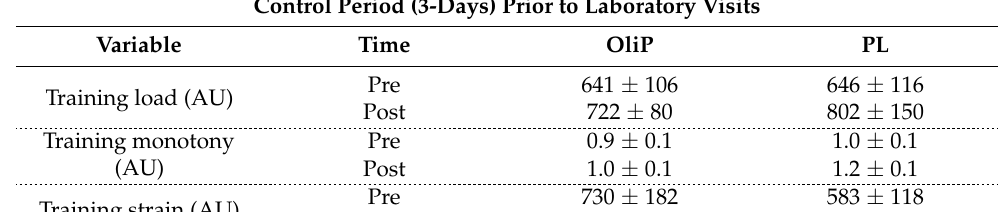
Table 3. Mean habitual exercise activity for both groups within the 3-day control period prior to visit 2 (pre-intervention) and 4 (post-intervention), as well as collated mean training parameters across the intervention